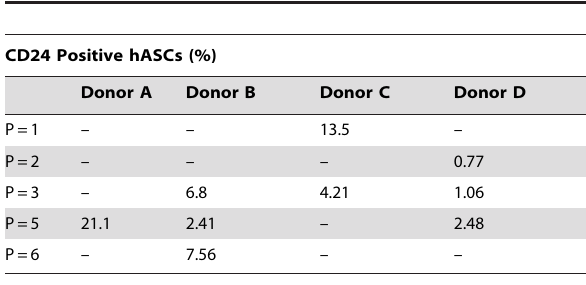
Table 4. CD24 expression on hASCs is variable and may be a function of donor and/or passage number.